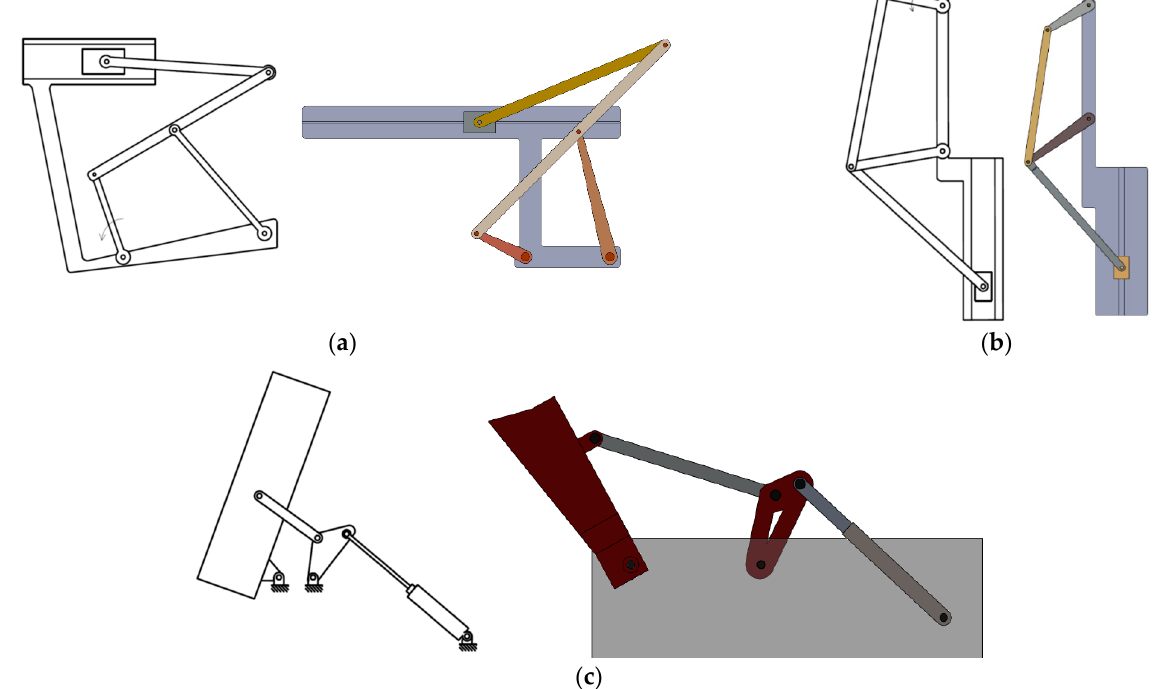
Figure 3. The three models used in the application—2D representation and 3D model: ( a ) crank slider mechanism 1; ( b ) crank-slider mechanism 2; ( c ) tilting mechanism.